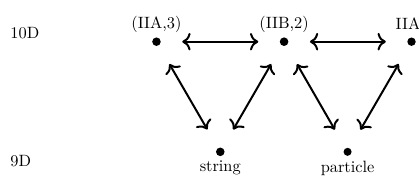
Figure 4 . this figure pictures the membrane T-duality discussed in the text. The longitudinal T-duality discussed in this paper is represented by the right triangle while the left triangle represents the membrane T-duality. This membrane T-duality maps (solutions of) (IIA,3) supergravity to (IIB,2)